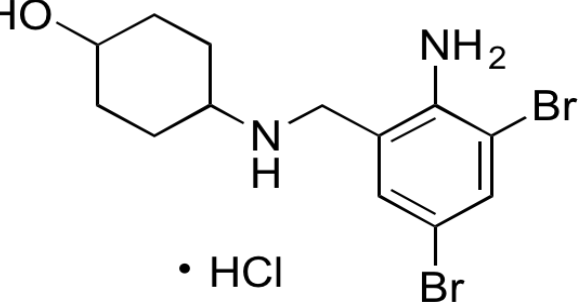
Figure 1. The structural formula of ambroxol hydrochloride .